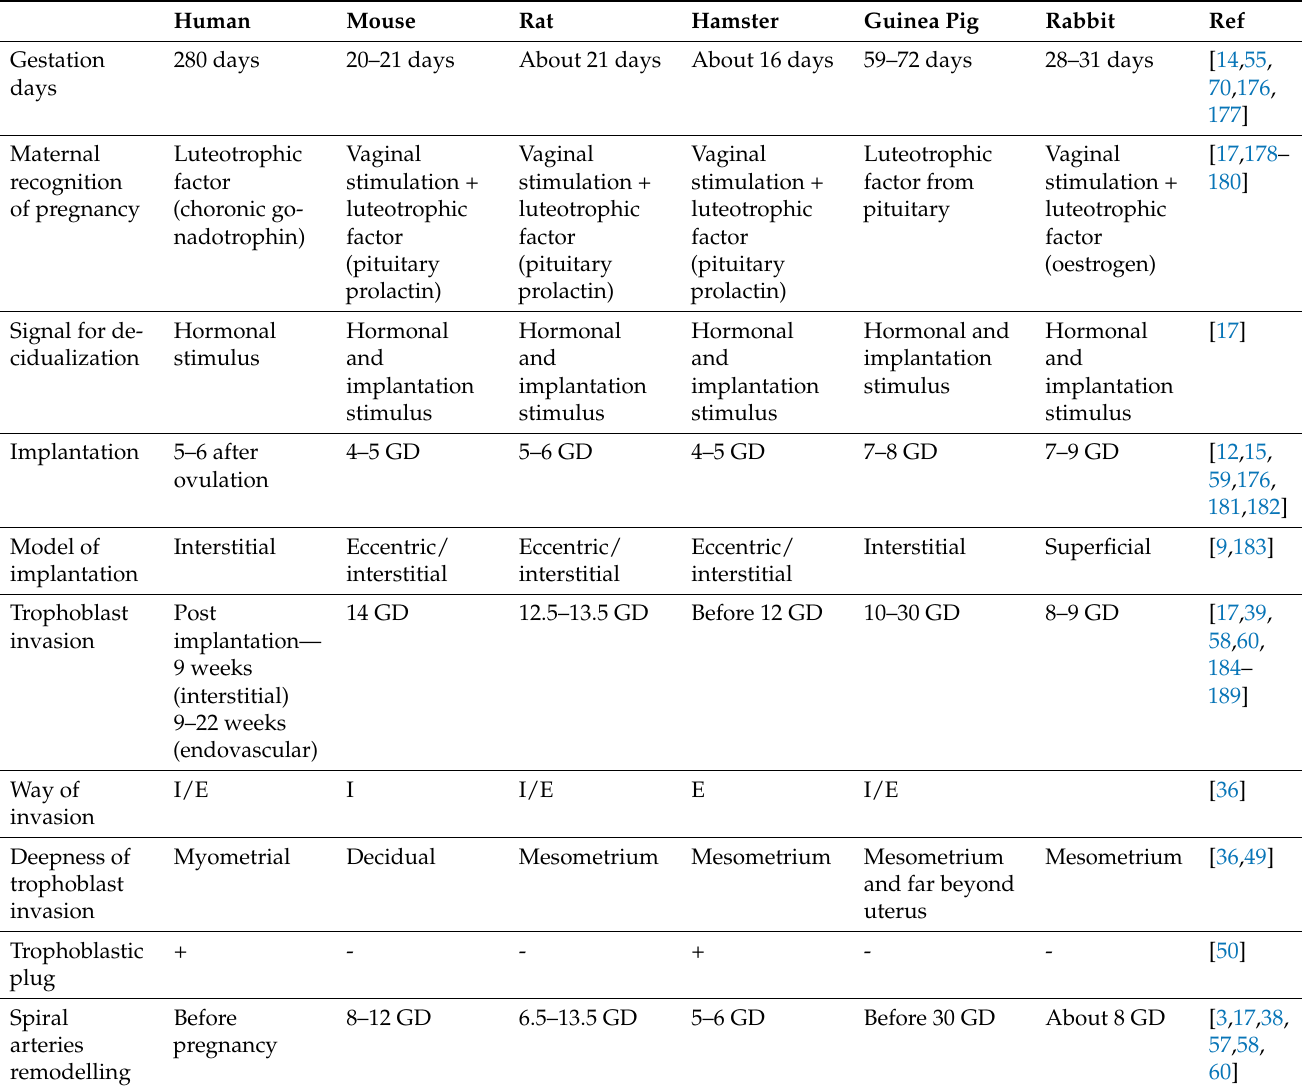
Table 2. Comparison of pregnancy-related features between humans and small mammals, i.e., rodents and